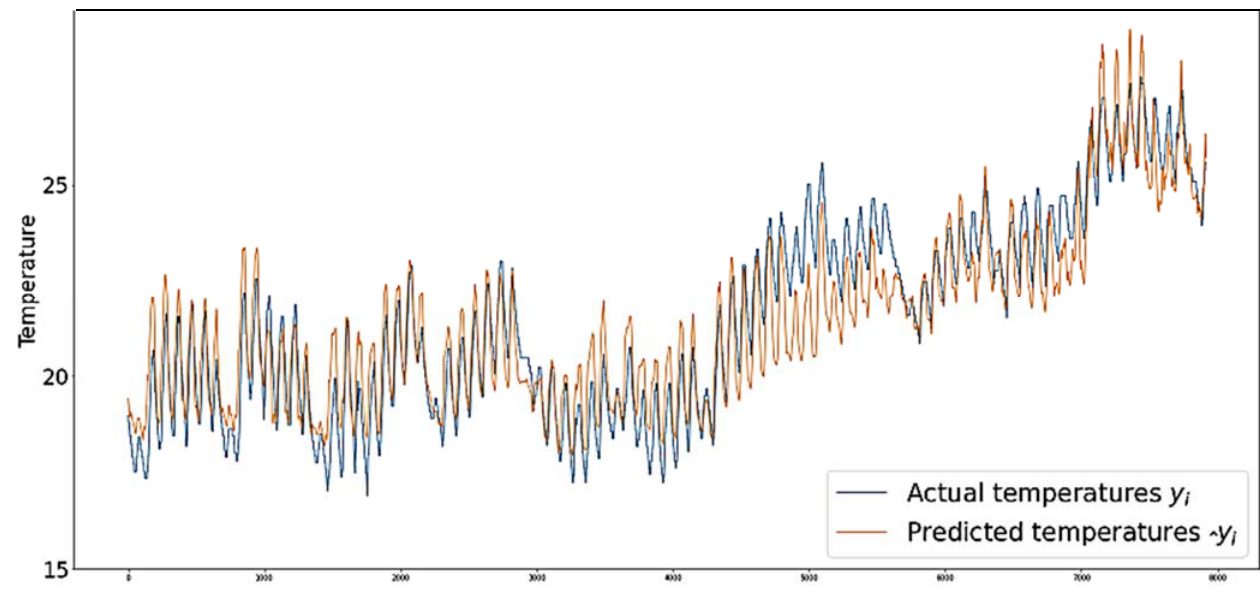
Figure 16. Plot of actual and predicted temperatures 2 h ahead for office 40 on the first floor.